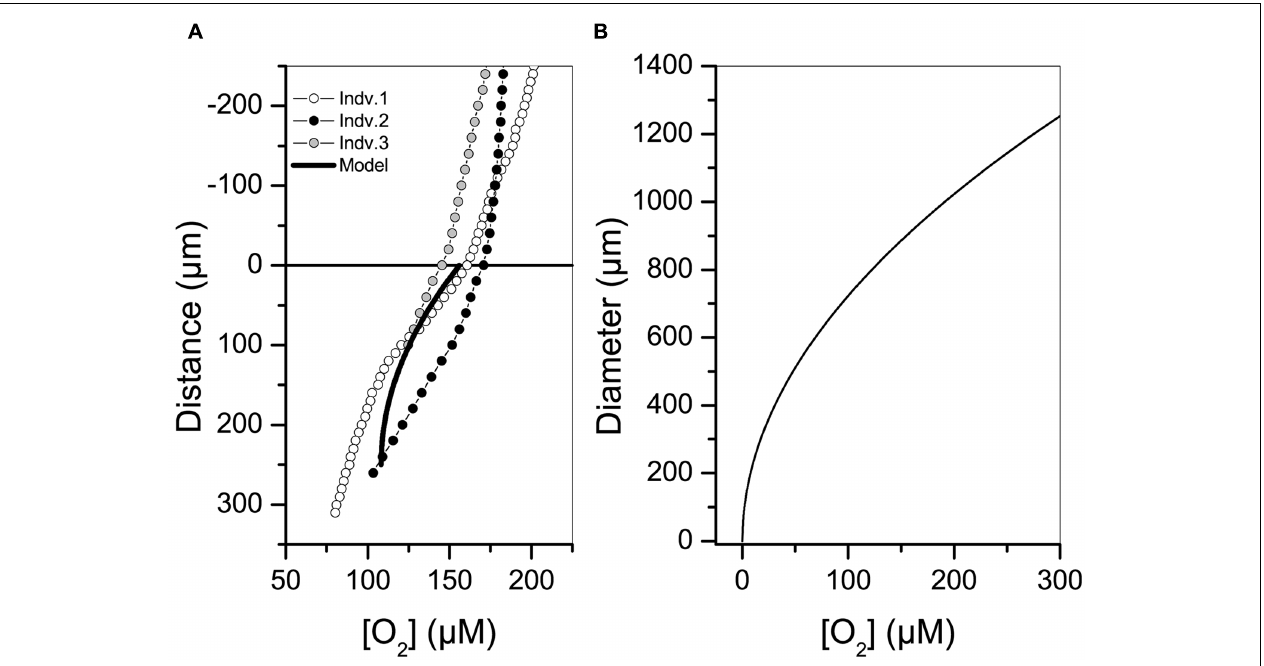
FIGURE 5 | (A) Intracellular oxygen concentration profiles in three gromiid specimens each having a diameter of approximately 500 µ m. Zero marks the surface of the gromiid and positive numbers show the distance from the surface into the gromiid cell body. The modeled oxygen concentration is shown as a black line. (B) Diameter at which the oxygen concentration reaches zero in the center of a spherical cell in relation to ambient oxygen concentration. TABLE 2 | Denitrification rates measured before and after addition of antibiotics together with aerobic respiration rates and intracellular nitrate concentration. Batch Individuals # Total biovol. (mm − 3